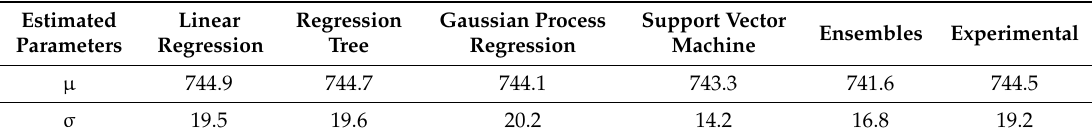
Table 6. The estimated parameters from the normal distribution. µ is the mean of the melt temperature and σ is the square root of the unbiased estimator of the